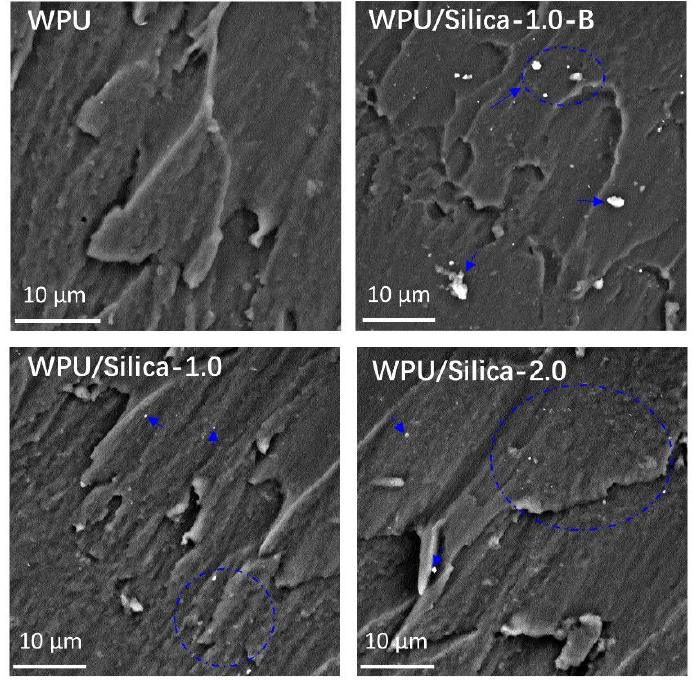
Figure 4 SEM images of cross sections of WPU and WPU/Silica coatings.